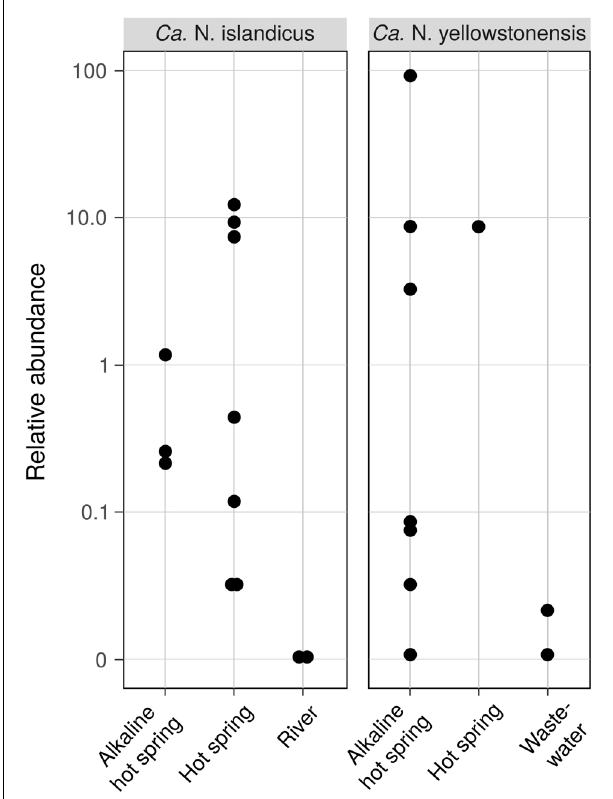
FIGURE 6 | Occurrence and abundance of AOA related to “ Ca. Nitrosocaldus islandicus” and “ Ca. Nitrosocaldus yellowstonensis” in different habitats based on the presence of closely related 16S rRNA gene sequences in all public 16S rRNA gene amplicon datasets. Data shown are log-scale relative abundances of 16S rRNA gene sequences with a minimum similarity of 97% in a sample ( n = 12 and n = 10 out of 93,045 total datasets for “ Ca. N. islandicus” and “ Ca. N. yellowstonensis,” respectively). Sequences of the Tibetan waste water data set where retrieved from BioSample SAMN03464927 of Niu et al.